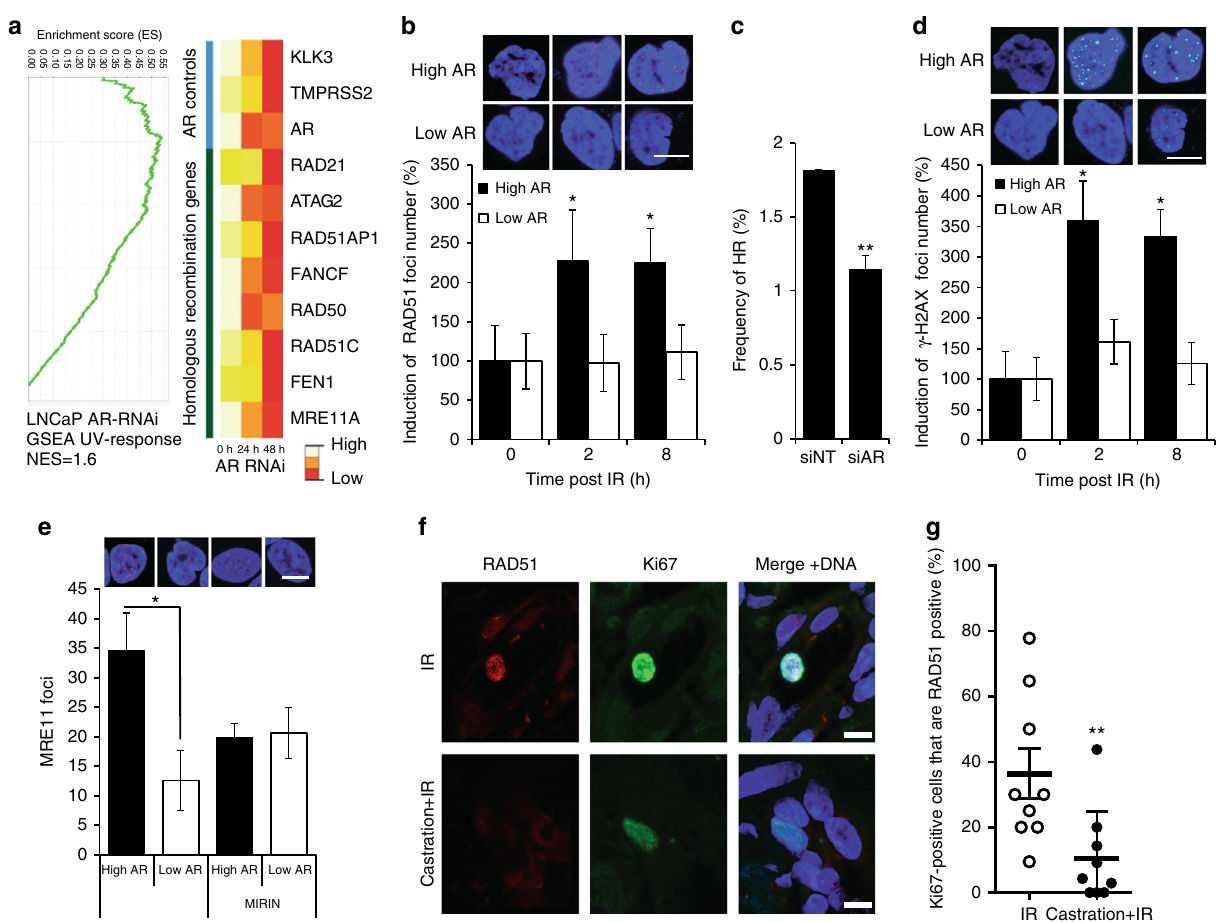
Fig. 1 AR signalling regulates homologous recombination (HR) and the DNA damage response. a Heat map showing expression of homologous recombination regulators following AR RNAi knockdown, AR transcript and known AR targets/controls are shown mined from the microarray data from LNCaP cells 19 . b Time course of formation of RAD51 foci showing high content cytometry-based quanti fi cation of RAD51 nuclear foci number per nucleus in ‘ low AR; and ‘ high AR ’ C4-2 cells in response to 10 Gy radiation. Statistical signi fi cance was determined using the Holm – Sidak method, with alpha